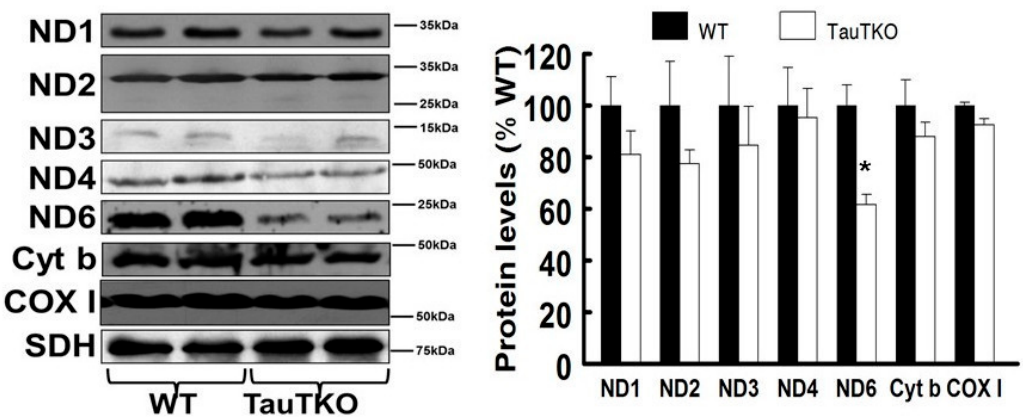
Figure 2. ND6 is reduced in TauTKO hearts. The mitochondrial fraction was isolated from homogenized hearts and then subjected to western blot analyses. The left panel shows representative gels for ND1, ND2, ND3, ND4, ND6, Cyt b (cytochrome b) and COX I (cytochrome c oxidase I), with succinate dehydrogenase (SDH) serving as the loading control. The right panel shows the means ± SEM of the mitochondrial protein/SDH ratio of 6–9 different hearts. Values are expressed relative to wild-type (WT), where WT is fixed at 100%. * p < 0.05.